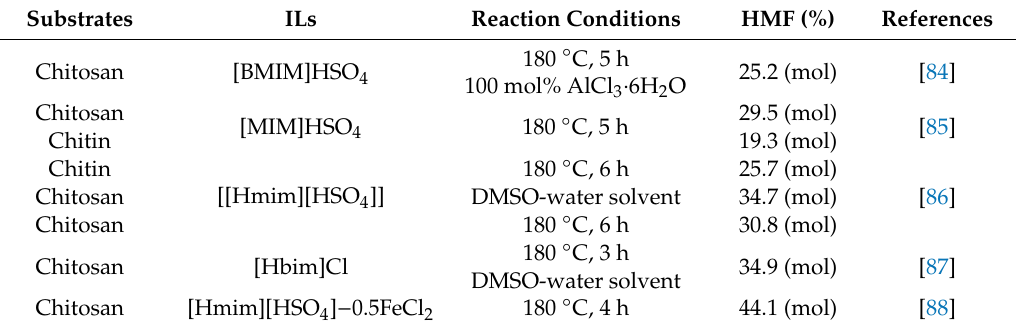
Table 3. HMF production from biomass using